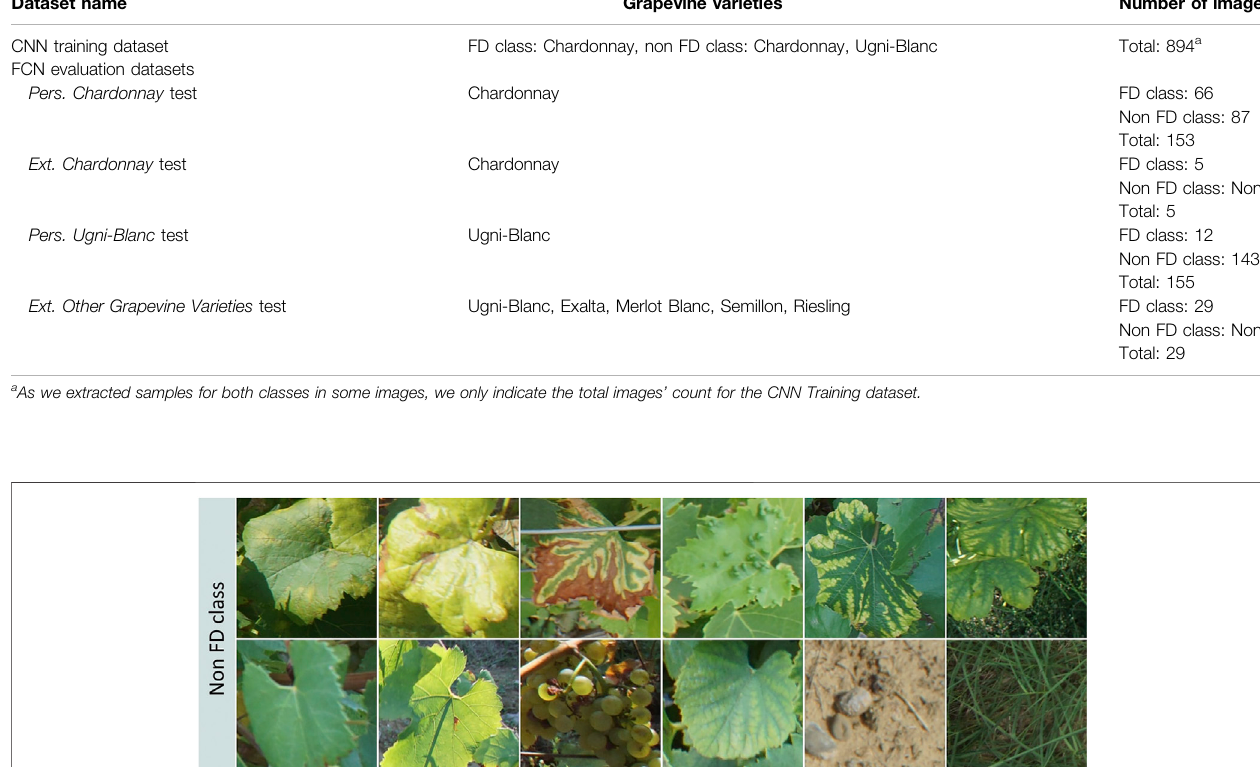
TABLE 1 | Summary of datasets used to train the CNN classi fi er and to evaluate the FCN model. Dataset name